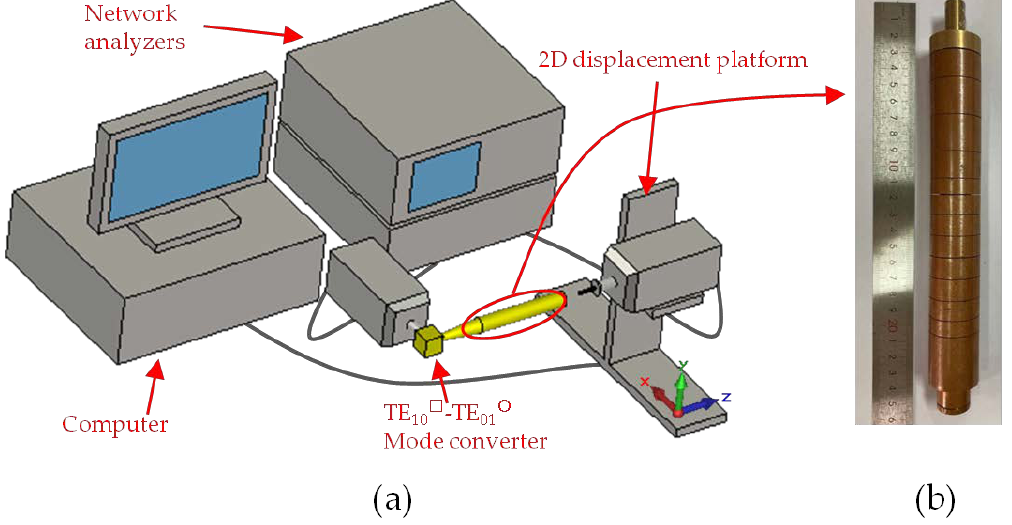
Figure 5. ( a ) The test systems of the converter and ( b ) The TE 03 -TE 01 mode converter after